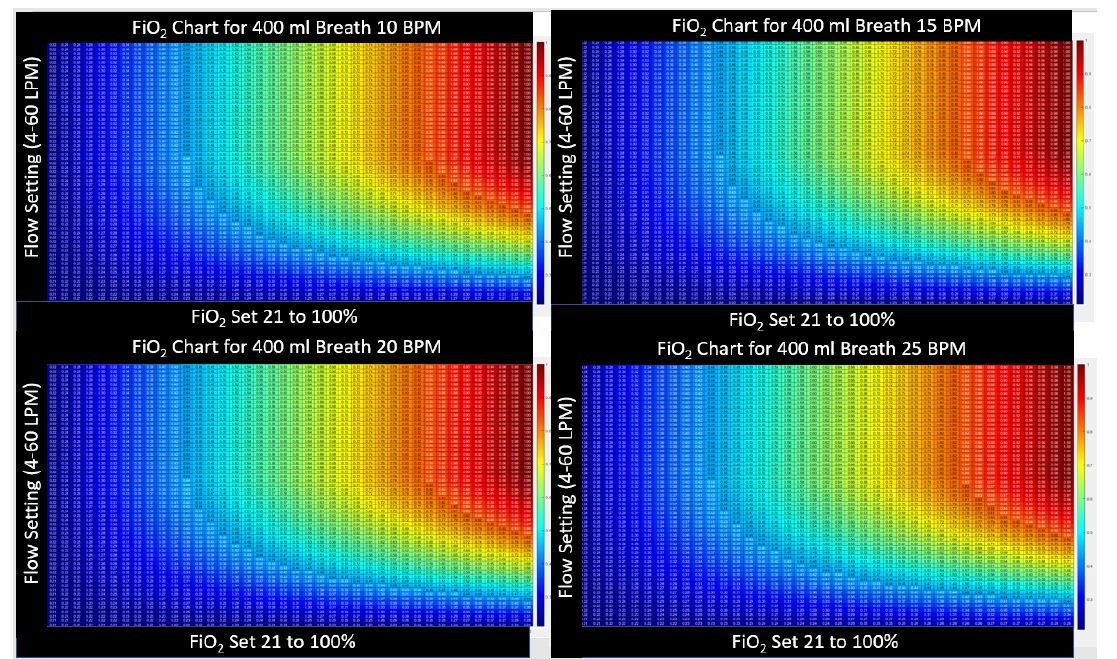
Figure 6. A side-by-side comparison F i O 2 for a consistent breath size (400 mL, with constant PIF, 36 LPM) at different respiratory rates (10, 15, 20 and 25 breaths per minute (BPM)). The four charts are completely identical, and this teaches that respiratory rate and therefore also minute ventilation does not impact F i O 2 during treatment with HFNT.